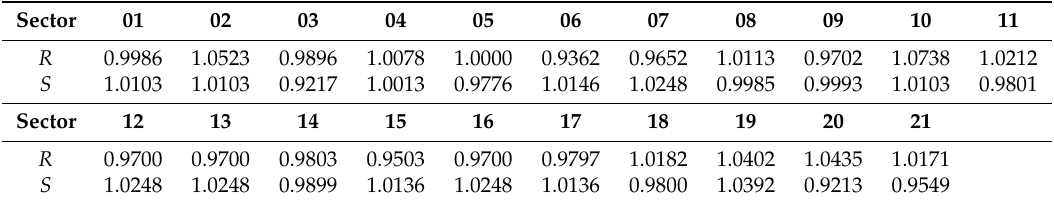
Table 7. The diagonal elements of the R matrix and S matrix.